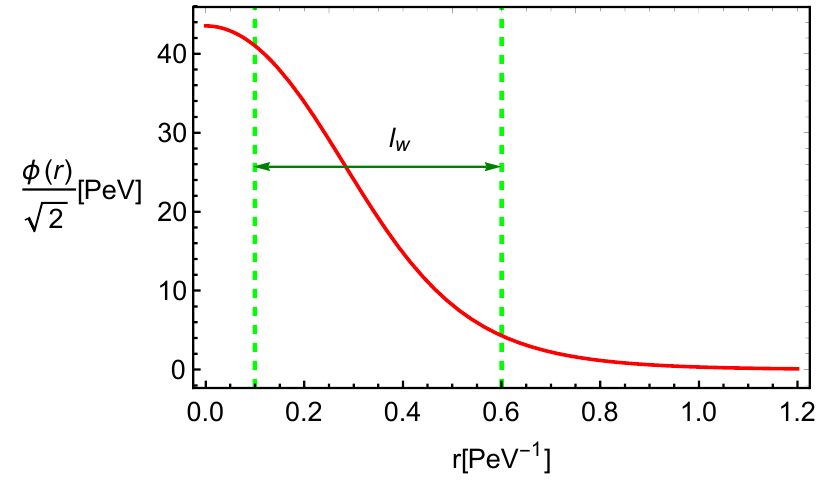
Figure 1 . For f a = 100 PeV , we display the total potential at three different temperatures within the aforementioned parameter space of the model.